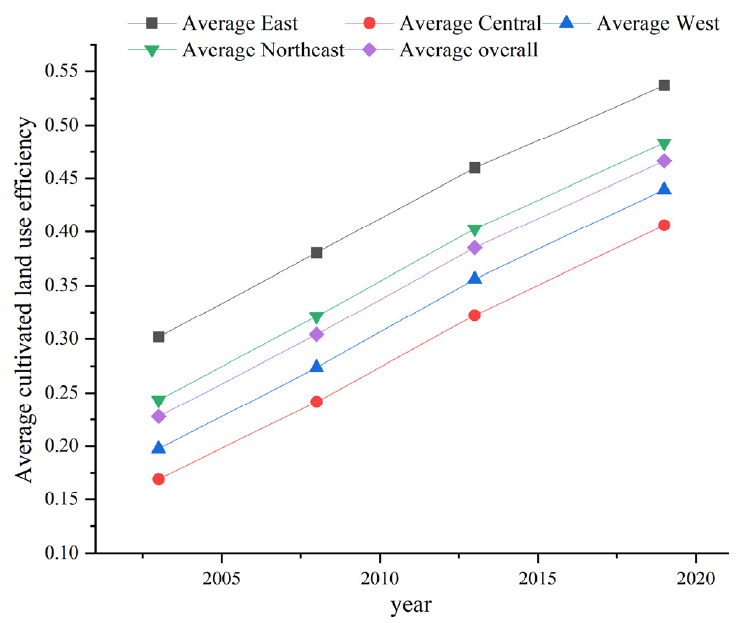
Figure 1. Trends of cultivated land use efficiency in China from 2003 to 2019.